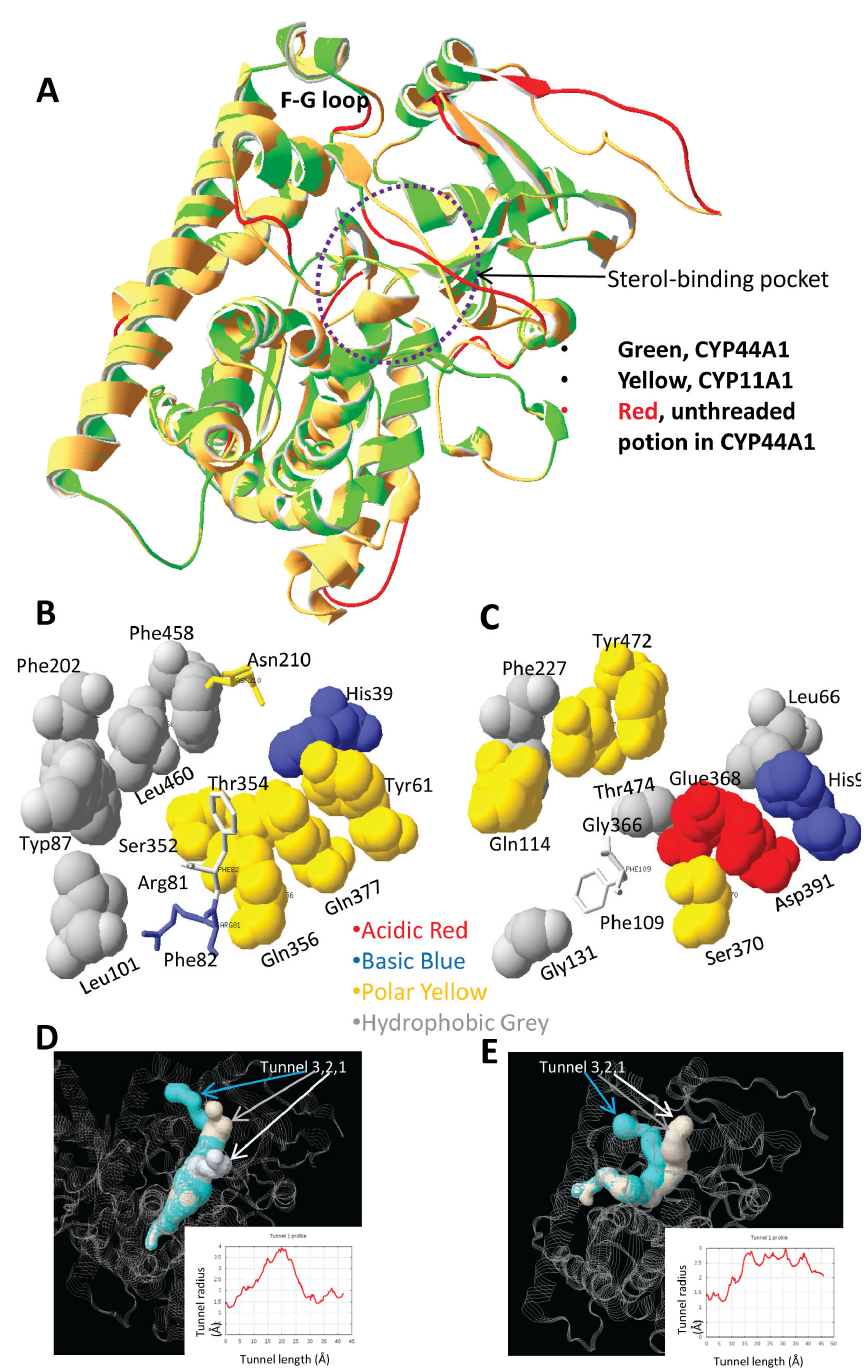
Figure 5. Comparison of putative steroid binding pockets from C. elegans CYP44A1 and CYP11A1. A. Superimposition of the C. elegans CYP44A1 threading model (green) with human CYP11A1 (yellow). The F-G loop, which attaches to the mitochondrial inner membrane, and putative steroid binding pocket are indicated. B. The sites responsible for steroid binding in human CYP11A1 (PDB, 3NA1). C. The sites corresponding to the human CYP11A1 steroid binding pocket in Figure 6B and S2. The colors of each site are as illustrated. The unmatched sites are shown in the stick structure, and the remainder of the sites is shown in the space-filling model. D. Three predicted channels involved in HEM and steroid binding in CYP11A1, which is in complex with adrenodoxin reductase (AdR). E. Three potential channels involved in steroid binding in CYP44A1. The channels were predicted using MOLE 2.0 online service (http://mole.upol.cz) [99]. doi: 10.1371/journal.pone.0076701.g005 PLOS ONE |